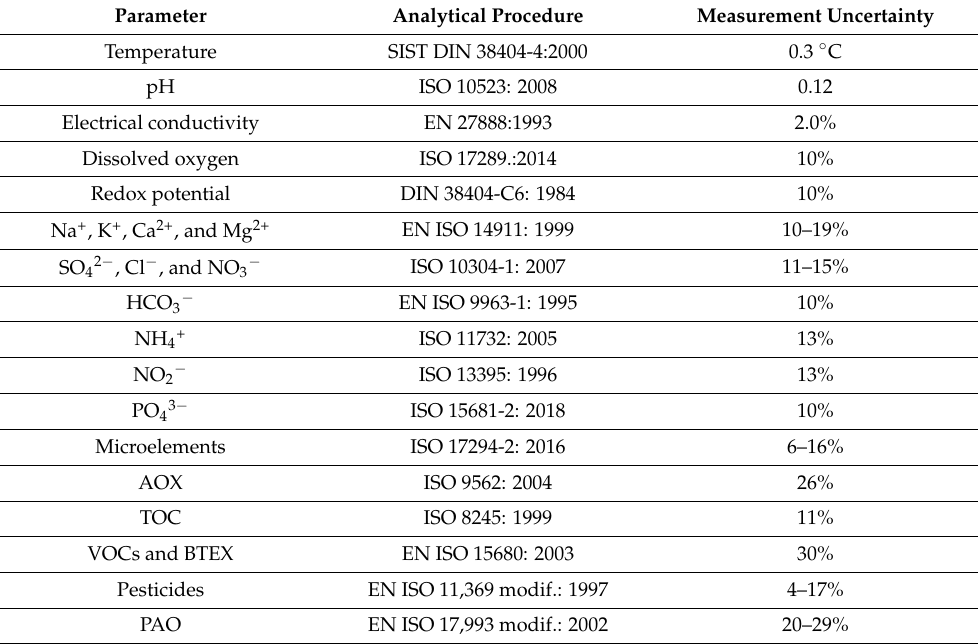
Table 2. Analyticalprocedureandmeasurementuncertaintiesforeachchemicalparameteringroundwater.